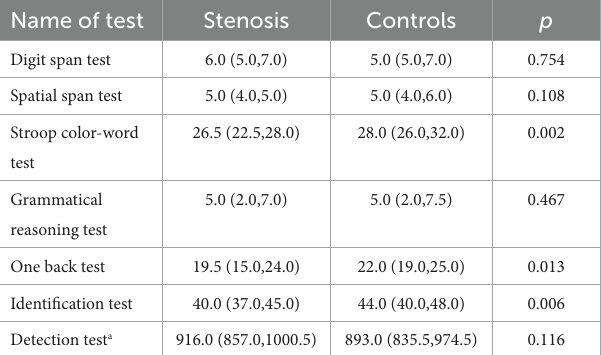
TABLE 2 The results of cognitive function test between stenosis group and control group.